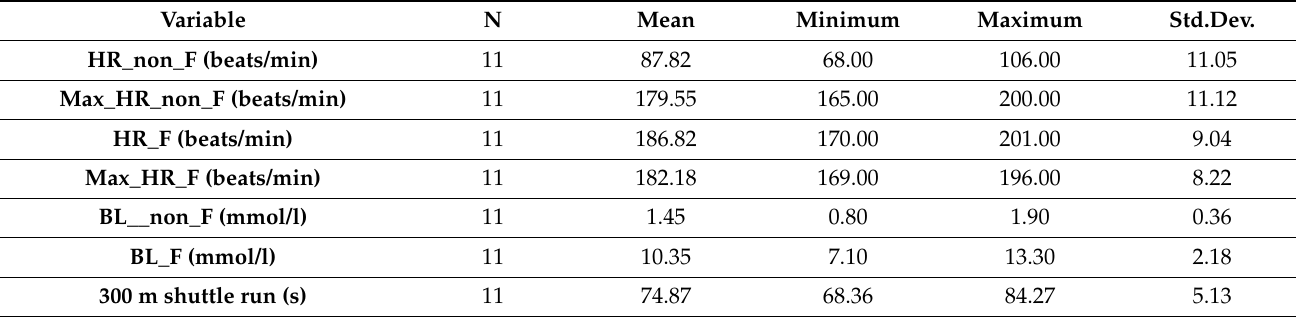
Table 2. Descriptive statistics of Heart Rate (HR) and Blood Lactate (BL) when players were under different physiological load. Variable N Mean Minimum Maximum Std.Dev.